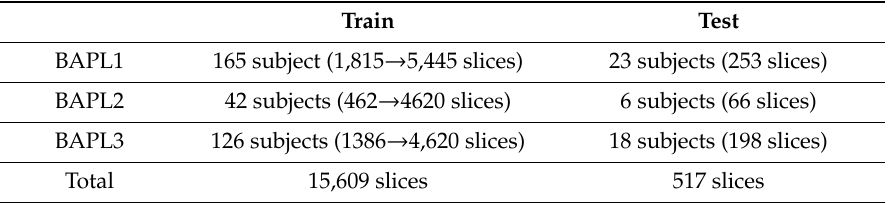
Table 2. Datasets after data augmentation for eight-fold cross-validation.